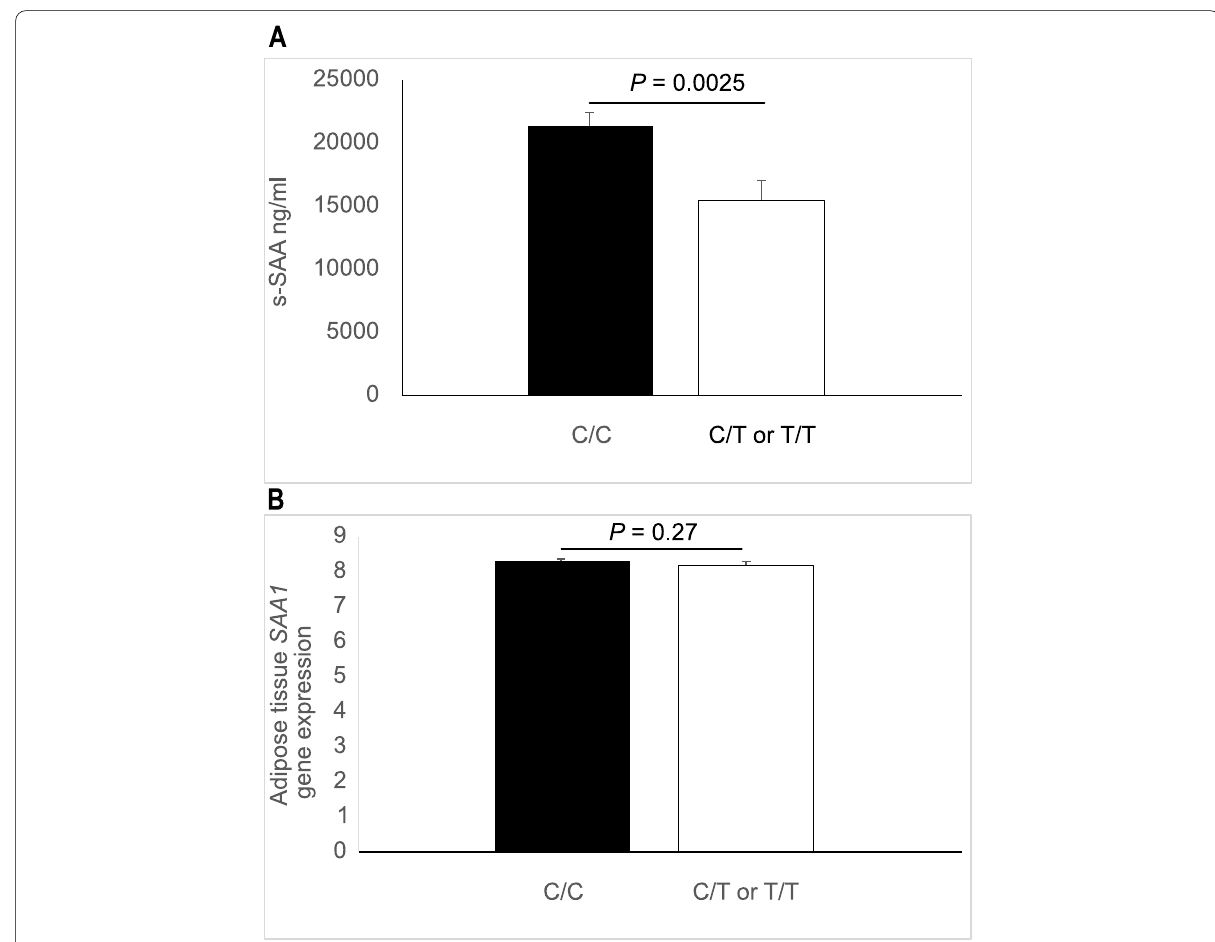
Fig. 1 A SAA serum levels (s‑SAA) and B adipose tissue SAA1 gene expression stratified by the rs1102495 genotype in the SibPair study. Data are presented as mean values adjusted for non independence among related individuals and standard